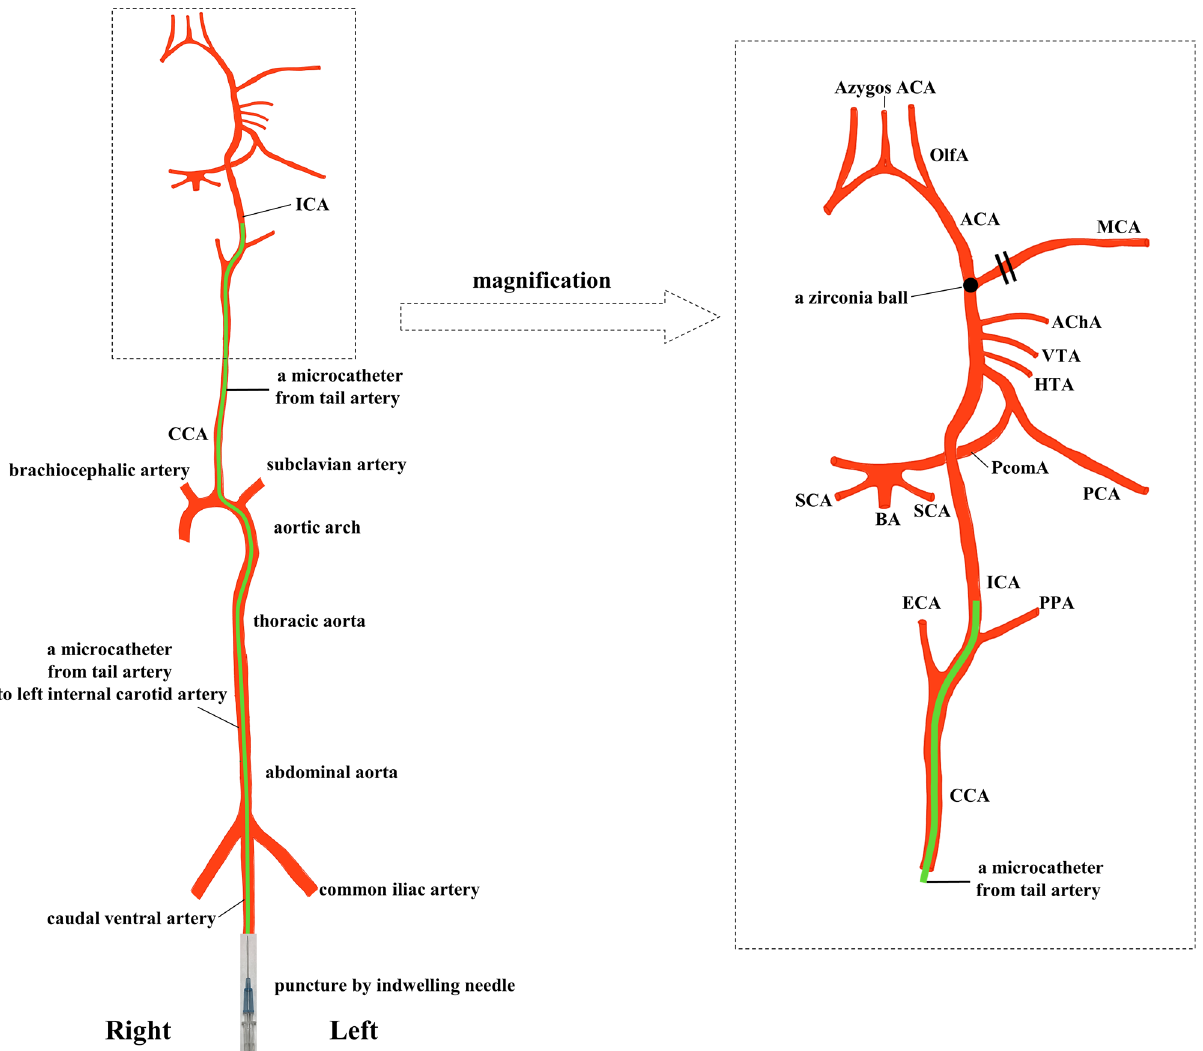
Figure 1. Schematic representation of the major rat arteries (view from the ventral) and the appropriate zirconia ball position during occlusion of the MCA. The microcatheter is inserted into ICA through caudal artery, aorta and CCA using fluoroscopic imaging. One zirconia ball is advanced in the microcatheter by slow injection and selectively occlude the ACA-MCA bifurcation. The zirconia ball block bold flow to the MCA, but not to the AChA, VTA and HTA. ACA anterior cerebral artery, AChA anterior choroidal artery, BA basilar artery, CCA common carotid artery, ComACA common (azygos) anterior cerebral artery, ECA external carotid artery, HTA hypothalamic artery, ICA internal carotid artery, MCA middle cerebral artery, OlfA olfactory artery, PCA posterior cerebral artery, PcomA posterior communicating artery, PPA pterygopalatine artery, SCA superior cerebellar artery, VTA ventral thalamic